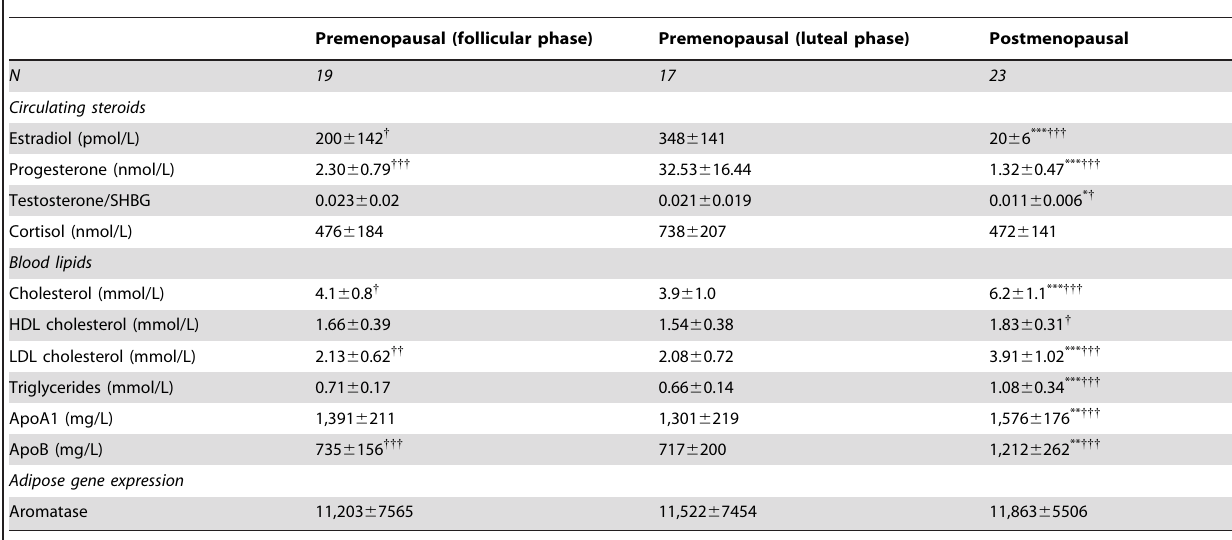
Table 2. Circulating levels of steroids and lipids and adipose aromatase transcript